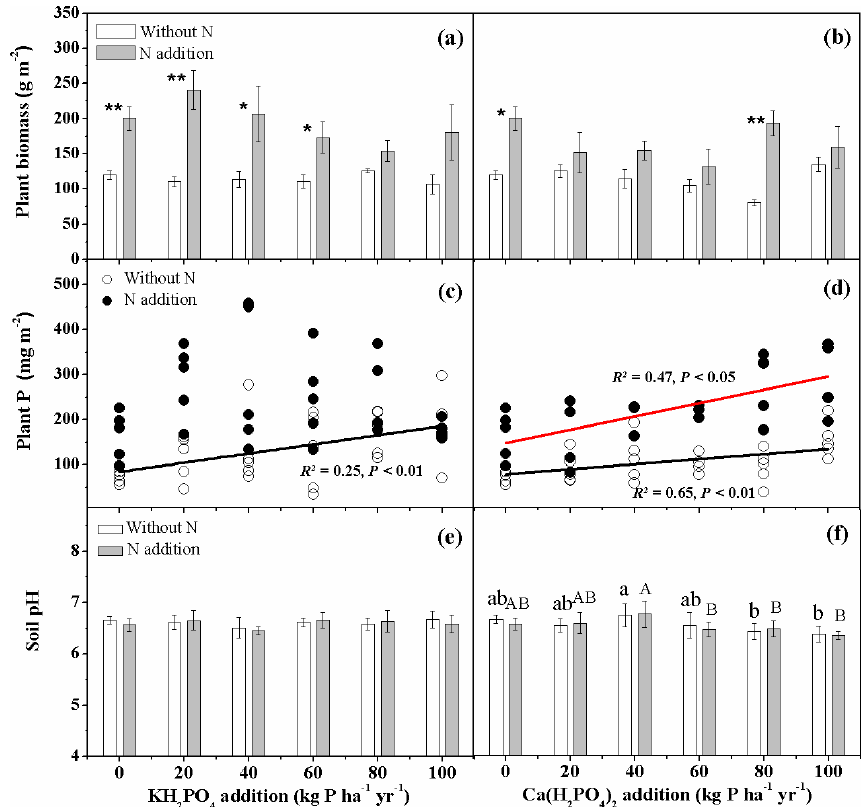
Figure 1. Aboveground plant biomass (a, b) , biomass-weighted phosphorus (P) uptake of three dominant plant species (c, d) and soil pH (e, f) as affected by KH 2 PO 4 and Ca ( H 2 PO 4 ) 2 additions with and without N inputs. Data are represented as mean ± standard error for panels (a) , (b) , (e) and (f) . Letters indicate significant differences between P rates of KH 2 PO 4 or Ca ( H 2 PO 4 ) 2 addition without N (lowercase letters) and with N addition (capital letters). Asterisks represent significance between N treatments within each P type and rate ( ∗ and ∗∗ for P < 0 . 05 and 0.01, respectively). Table 2. Results ( F values) of three-way ANOVAs on the effect of phosphorus (P) fertilizer type ( P t ) , P addition rate ( P r ), and nitrogen ( N ) addition and their interactions on soil inorganic phosphorus fractions of variscite (Al-P), strengite (Fe-P), dicalcium phosphate (Ca 2 -P), octacalcium phosphate (Ca 8 -P), hydroxylapatite (Ca 10 -P), occluded phosphate (O-P), Olsen-P, total inorganic phosphorus (TIP), and soil total P (TP) with KH 2 PO 4 and Ca ( H 2 PO 4 ) 2 addition. Al-P Fe-P Ca 2 -P Ca 8 -P Ca 10 -P O-P